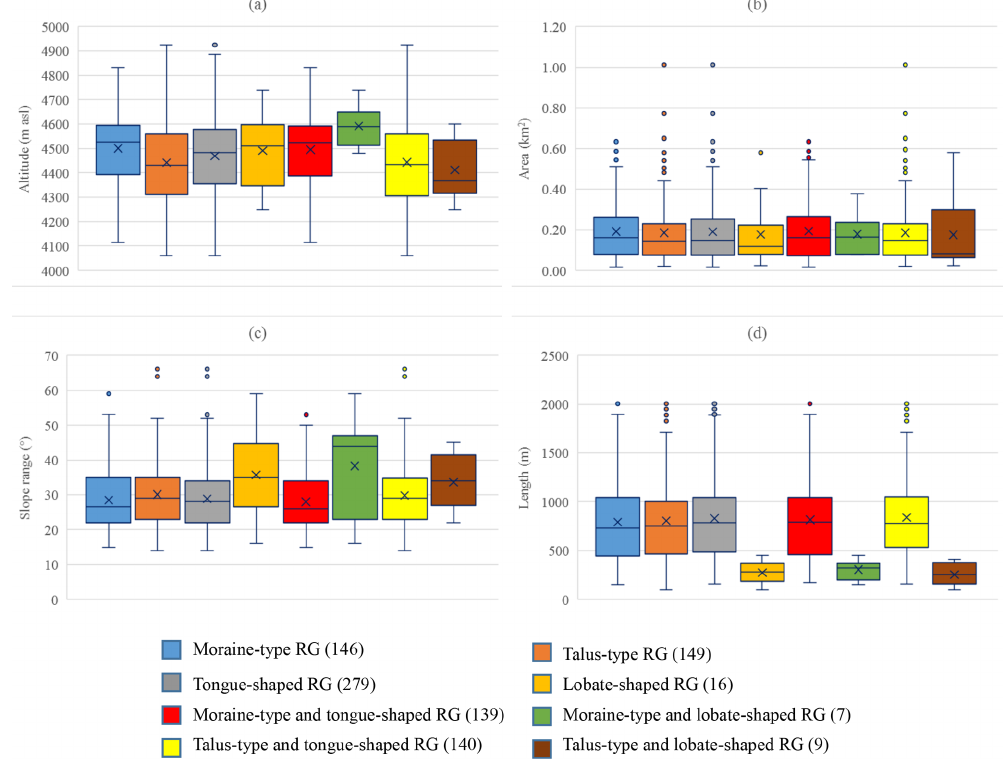
Figure 4. Box plots illustrating the distributional characteristics of rock glaciers in Daxue Shan: (a) average altitude (ma.s.l.), (b) area (km 2 ) , (c) range in the gradient of the slope ( ◦ ), and (d) length (m). Box plots represent 25–75% of all values, the caps at the ends of the vertical lines represent 10–90% of values, and the line in the centre of each box indicates the median value. The numbers of each rock glacier type are in brackets in the